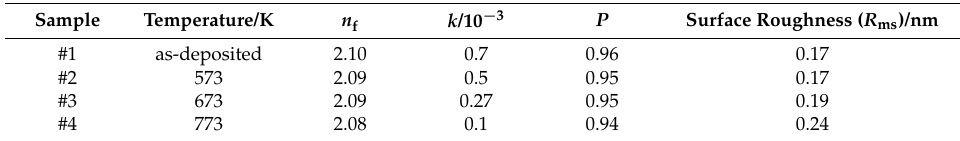
Table 1. The refractive index ( n f ) and the extinction coefficient ( k ) at a wavelength of 550 nm of Ta 2 O 5 films were obtained by fitting the spectra. The packing density ( P ) was calculated by Equation (1) [26] and surface roughness ( R ms ) was determined by AFM